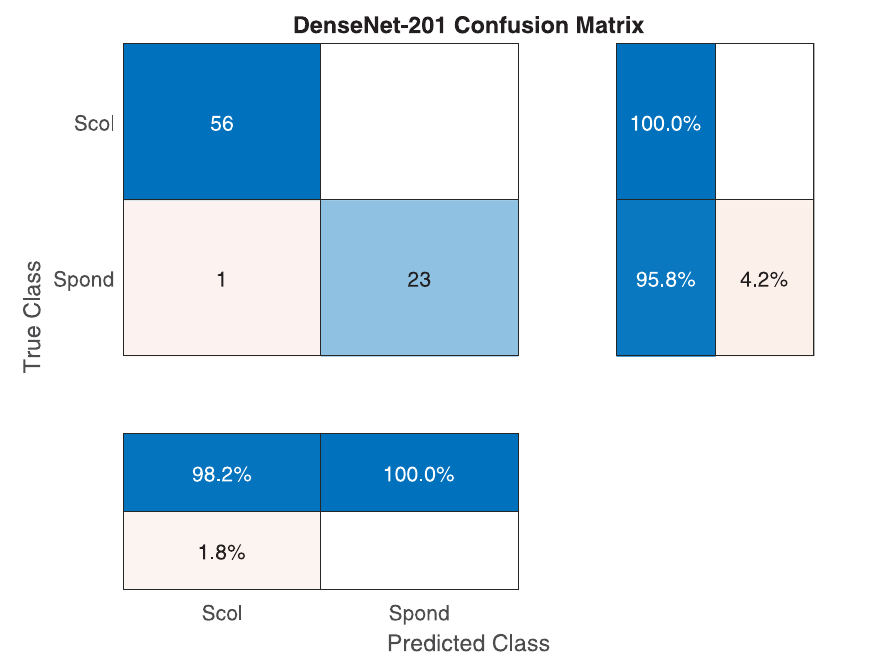
Fig 10. The RestNet-101 sample confusion matrix for scoliosis vs spondylolisthesis classification.